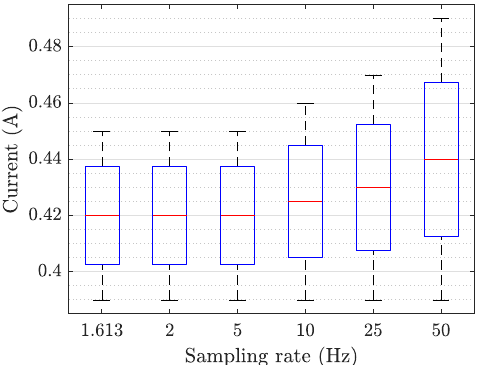
Figure 9. Whisker and box plot of the current consumed by the single-phase IMPEC system connected to a storage unit and operating at different sampling